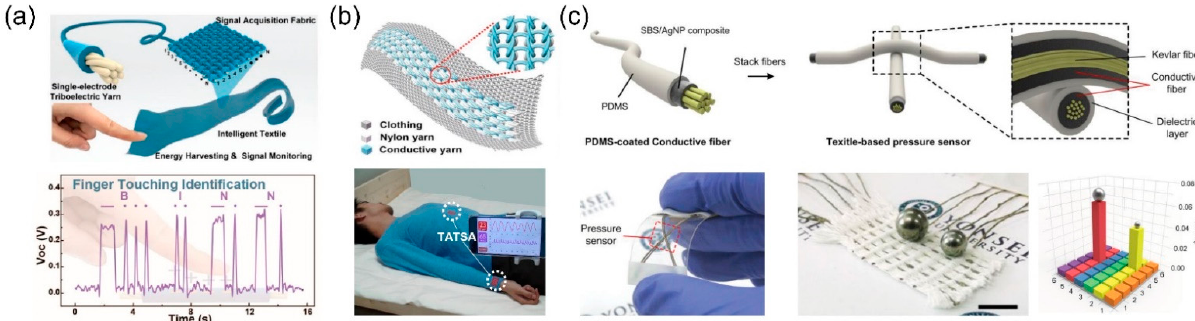
Figure 15. ( a ) Signal acquisition fabric made of single-electrode triboelectric yarns for pressure sensing; Reprinted with permission from Ref. [113] 2020, American Chemical Society. ( b ) triboelectric all-textile sensor array combined with cloth for respiratory wave measurements [114]; and ( c ) fabrication of the pressure sensor based on the conductive fiber made of SBS/AgNP/Kevlar fiber. Reprinted with permission from Ref. [17] 2015, Wiley − WCH.